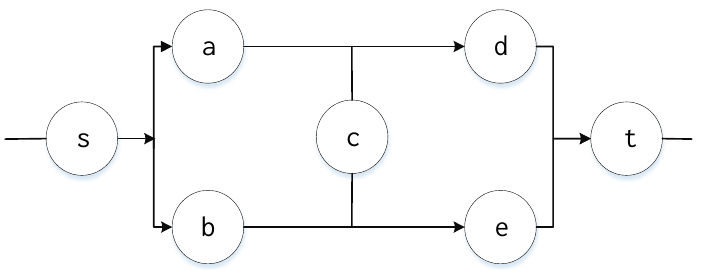
Figure 4. Directed MFN of goods shipped from northern Taiwan to the south.